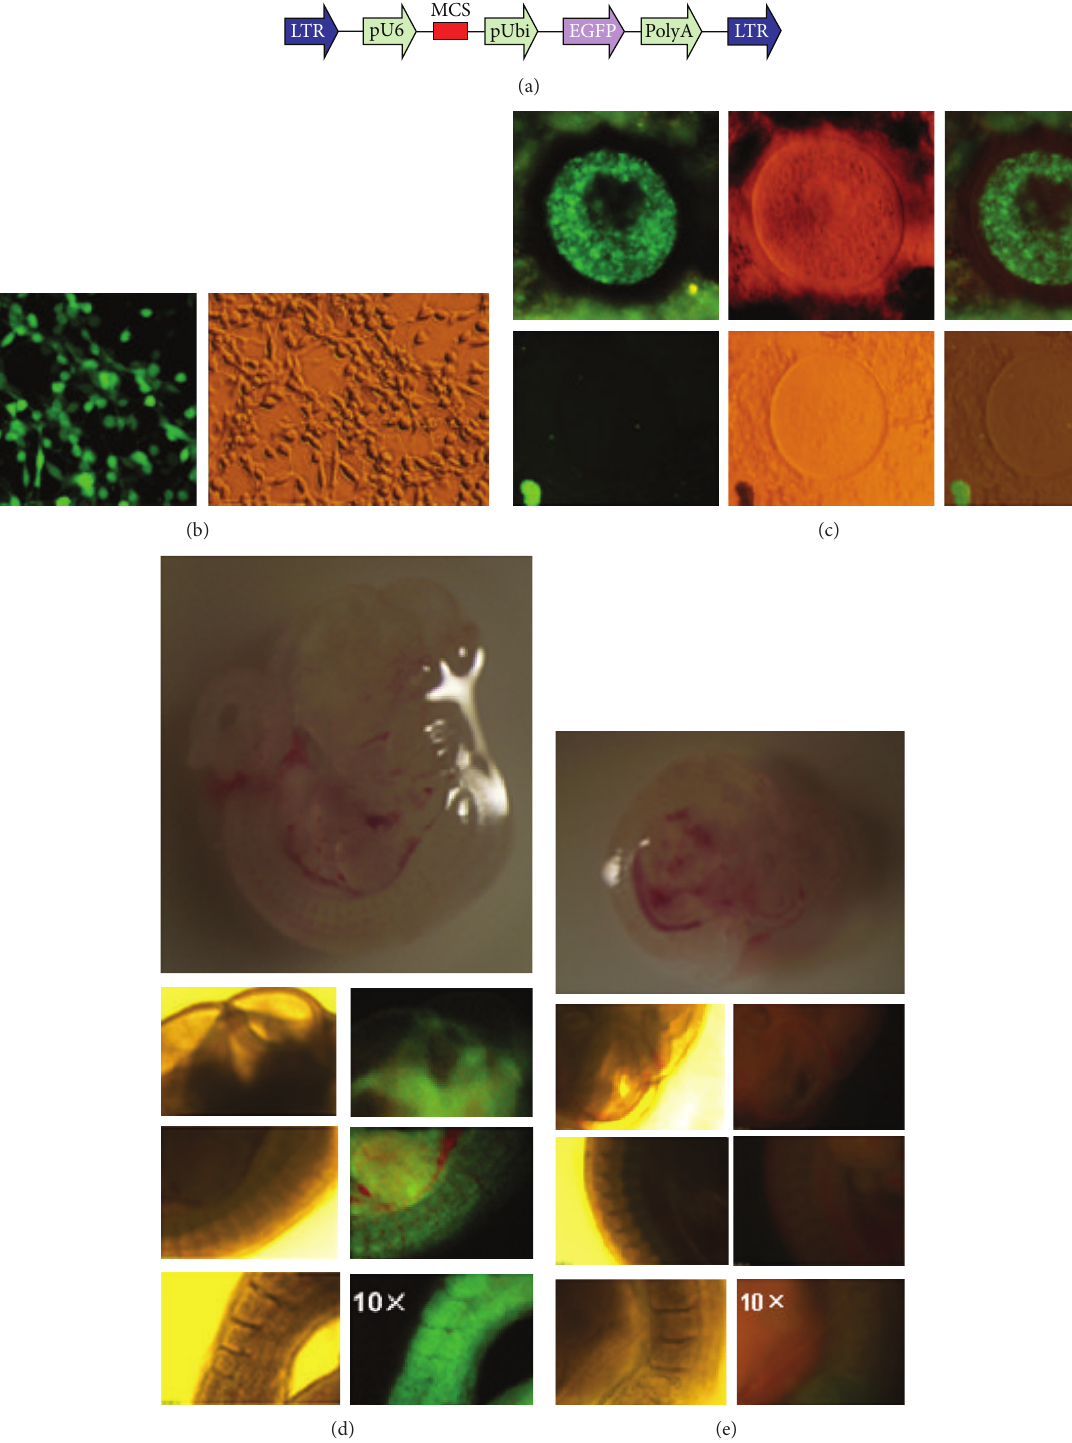
Figure 2: Transfection of OSCs and transplantation into ovaries of recipient mice. (a) Schematic diagram for the lentivirus vector with EGFP. LTR, long terminal repeat; pUbi, ubiquitin promoter. (b) Immunofluorescence-based analysis (right) and bright field view (left) of OSCs transfected with EGFP vector. (c) The ovaries from the recipient were dissected 12 days after injection with EGFP-expressing OSCs and the oocytes within these ovaries were visualized under fluorescence microscope. EGFP-positive oocyte (above) displayed fluorescence and the negative one (below) showed no fluorescence. (d, e) The fetuses from the mated recipients were obtained and observed under fluorescence microscope under the same exposure time. (d) On the top is the overview of the EGFP-positive fetus under stereoscope and at the bottom are the images from the head, body, and tail section showing fluorescence. (e) On the top is the EGFP-negative fetus under stereoscope and at the bottom are the images showing no signal in three sections under fluorescence